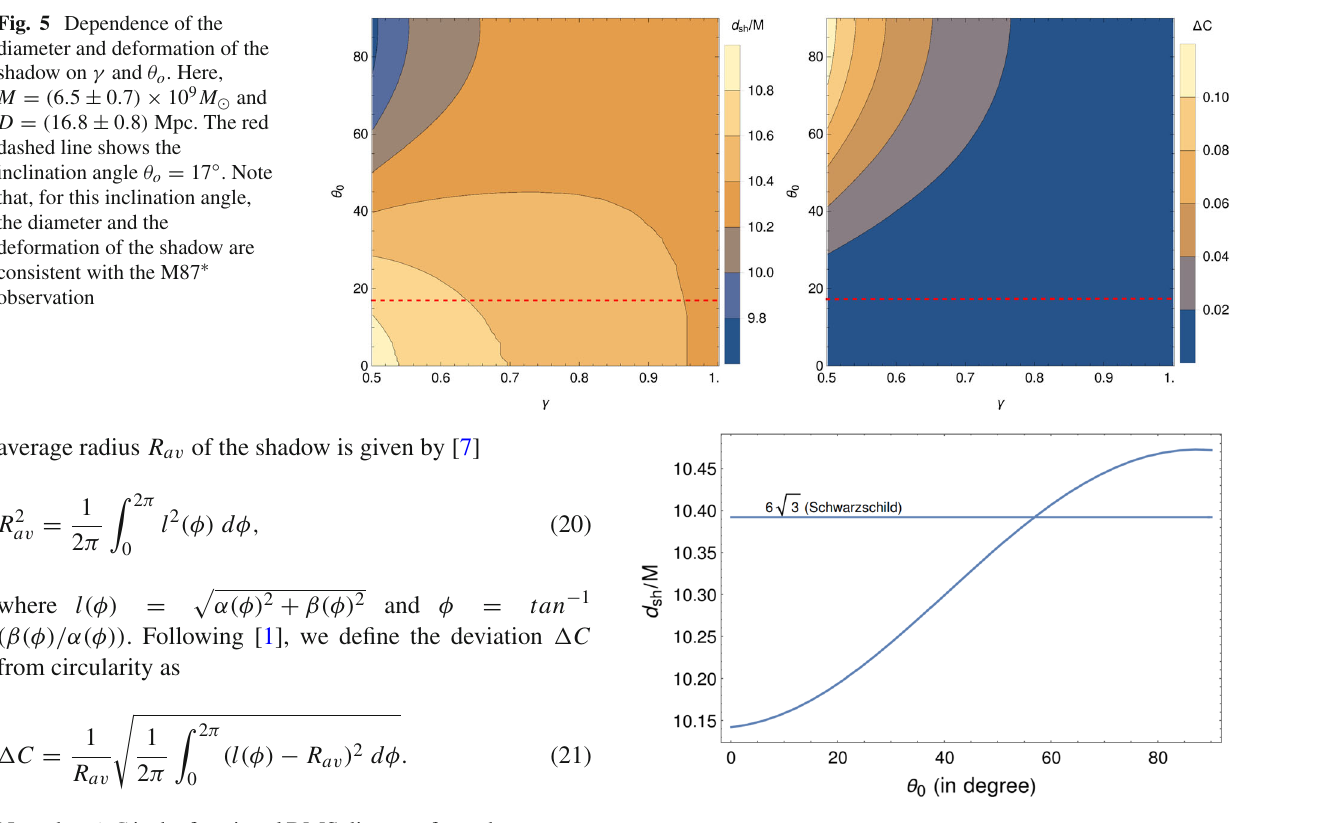
θ o , the maximum deviation from circularity occur for the GI spacetime. However, with increasing γ ( > 1), the shadow size slowly increases from the Schwarzschild value 6 for a given higher inclination angle and decreases for a given lower inclination angle. Therefore, for γ > 1, the maximum and minimum size respectively occur for the GI spacetime with θ o = 90 ◦ and θ o = 0 ◦ . These maximum and mini- mum values are respectively given by d sh / M (cid:12) 10 . 47 and d sh / M (cid:12) 10 . 14 (see Fig. 6). For any other values of γ ( > 1) and θ o , 10 . 14 (cid:2) d sh / M (cid:2) 10 . 47. For the GI spacetime with = 17 ◦ , d / M (cid:12) 10 . 18 and (cid:12) C (cid:12) 0 . 002, which are con- θ o sh sistent with the observation. Therefore, we find that, for